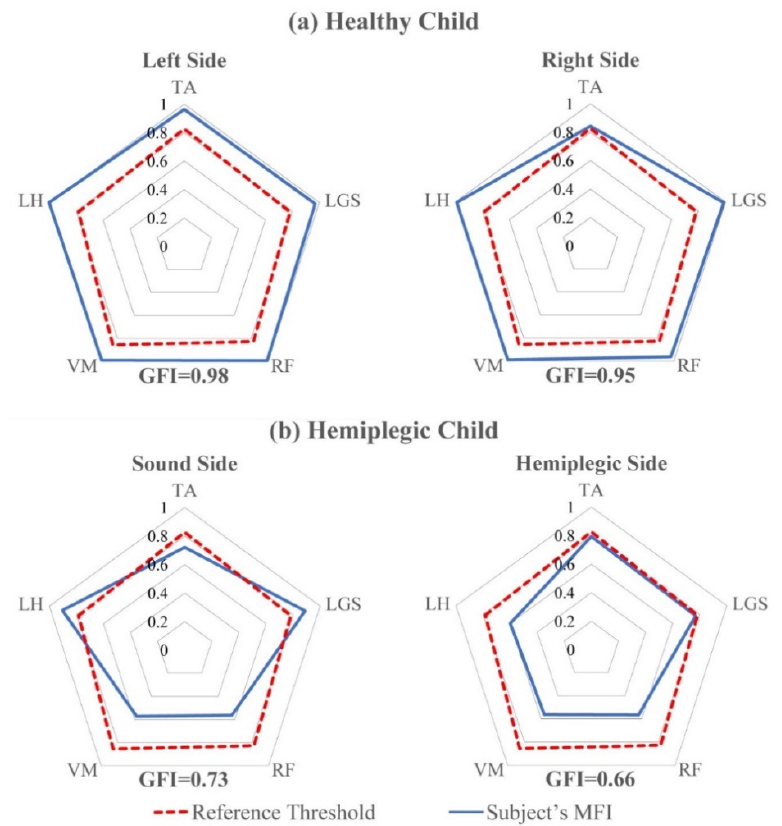
Figure 5. Radar diagram representation of MFI values for ( a ) a healthy child and ( b ) a hemiplegic child, both sides. The corresponding GFIs are reported under each diagram. The dotted red lines join the reference thresholds R Th for each muscle. The blue lines join the MFI values of the subject. Muscles: Tibialis Anterior (TA), Gastrocnemius Lateralis (LGS), Vastus Medialis (VM), Rectus Femoris (RF), and Lateral Hamstring (LH).